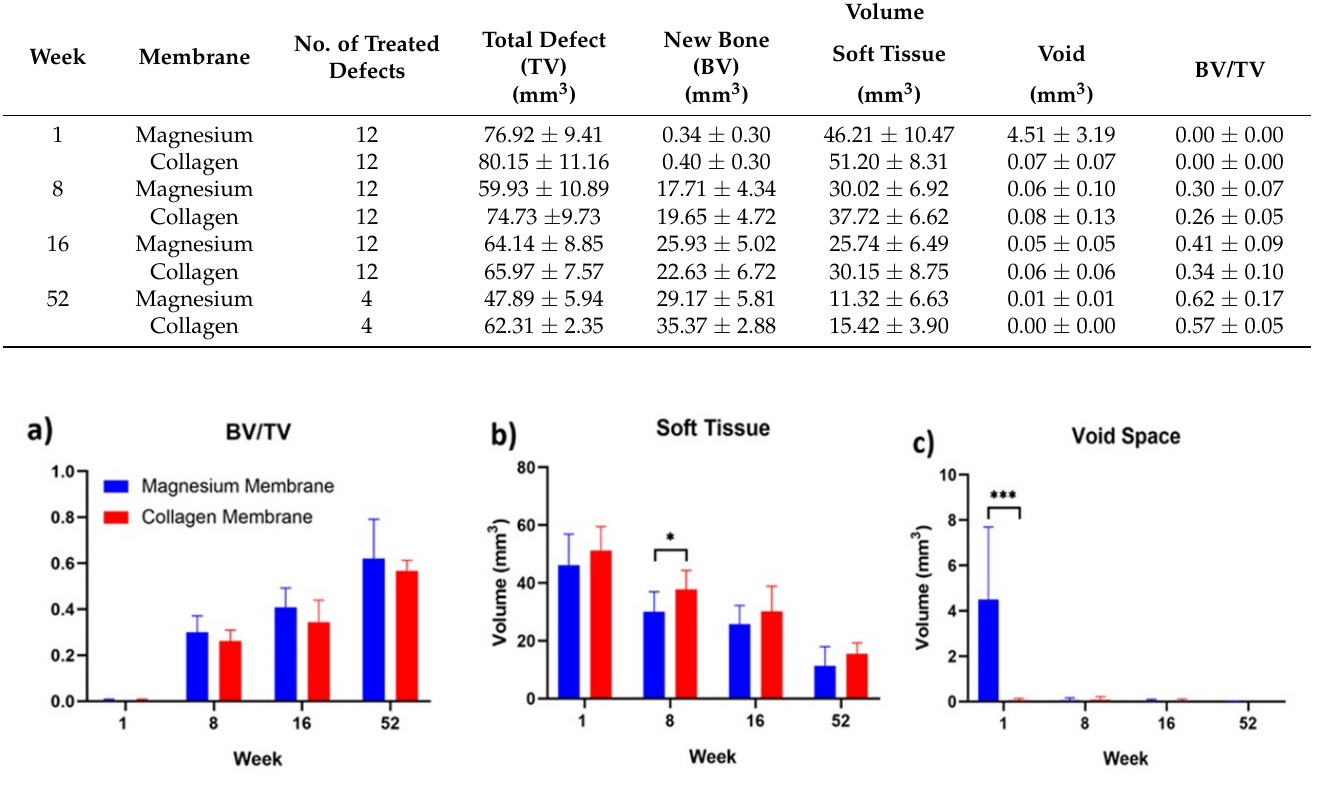
Figure 2. Volumetric measurements of GBR defects treated with either a magnesium membrane (blue) or collagen membrane (red): ( a ) New Bone Volume/Total Defect Volume; ( b ) Soft Tissue Volume; ( c ) Void Space Volume. Standard deviation and statistical significance are shown. p ≤ 0.05 is represented by “*” and p ≤ 0.001 is represented by “***”. Table 1. μ CT volume measurements for GBR defects treated with either a magnesium membrane or collagen membrane.